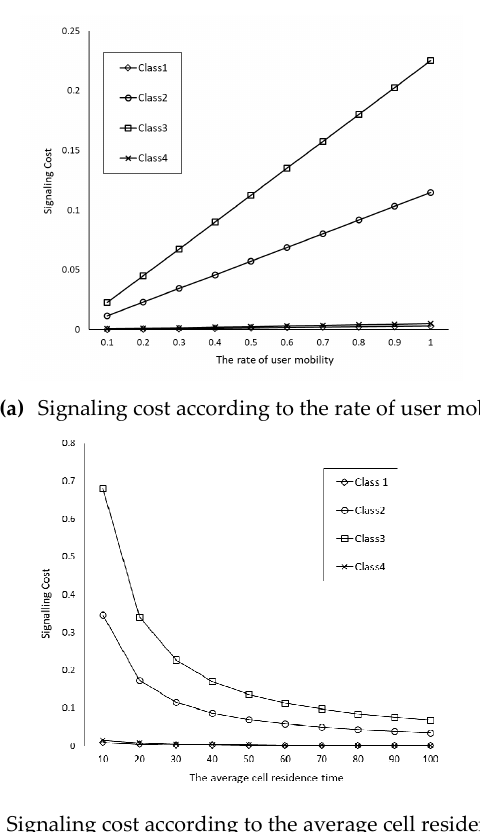
Figure 3. Signaling cost according to the rate of user mobility ( a ) and the average cell residence time ( b ).